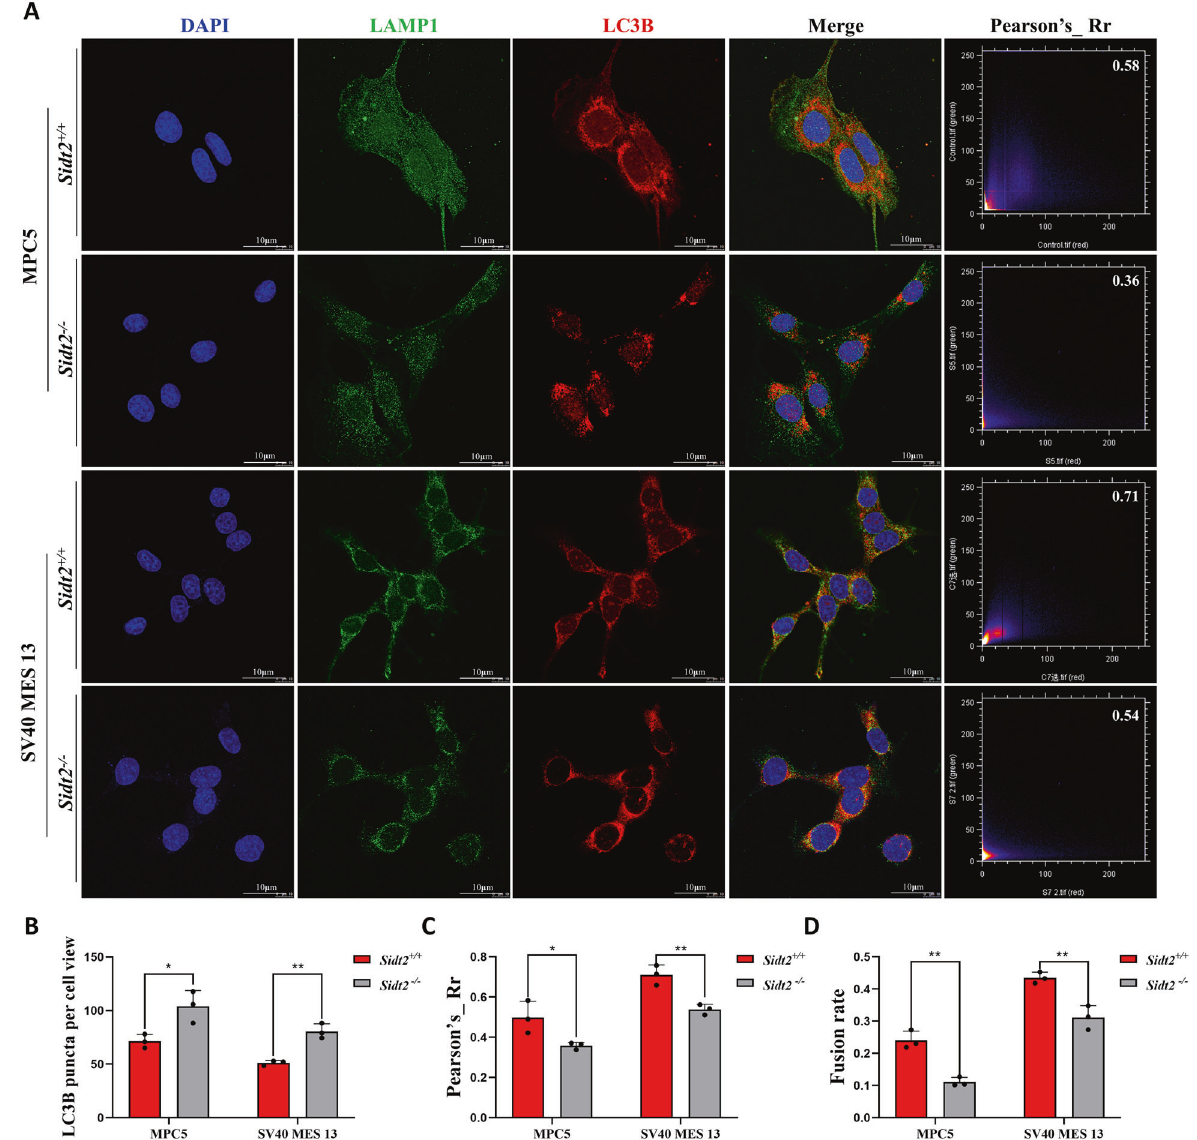
Fig. 5 Autophagosome and lysosome fusion is prevented after Sidt2 deletion. A Immuno fl uorescence co-localization of LC3B and LAMP1 in MPC5 and SV40 MES 13 cells before and after Sidt2 knockout, analysis with Pearson ’ s correlation coef fi cient; B comparison of LC3B fl uorescence points before and after Sidt2 knockout in MPC5 and SV40 MES 13 cells; C comparison of Pearson ’ s correlation coef fi cient before and after Sidt2 knockout in MPC5 and SV40 MES 13 cells; D comparison of the fusion rate before and after Sidt2 knockout in MPC5 and SV40 MES 13 cells (the ratio of the number of co-localized fl uorescent spots of LAMP1 and LC3B to the number of fl uorescent spots of LAMP1); * P < 0.05, ** P <